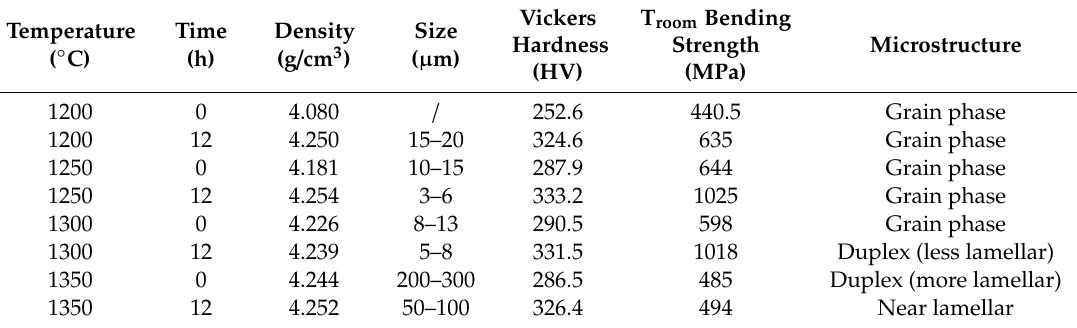
Figure 10. Microstructure of Ti-48Al-2Cr-8Nb alloy prepared by the MP powder with different sintering Table 1. Performance parameters of Ti-48Al-2Cr-8Nb